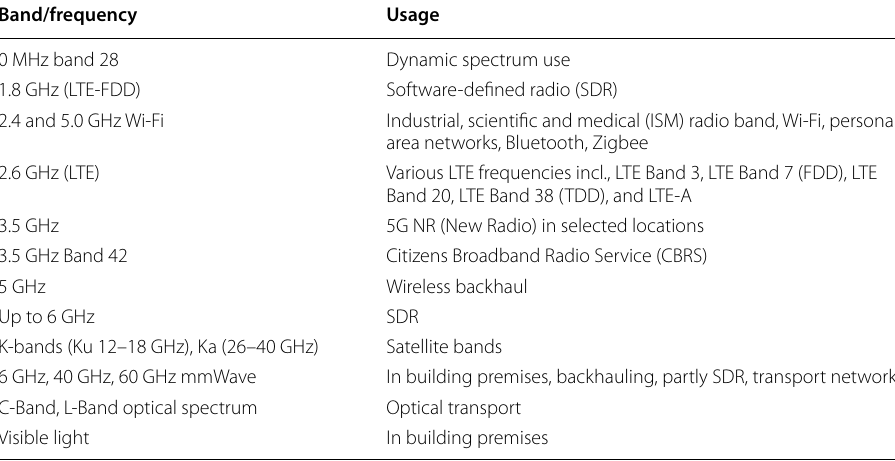
Table 1 The use of spectrum in 5G systems